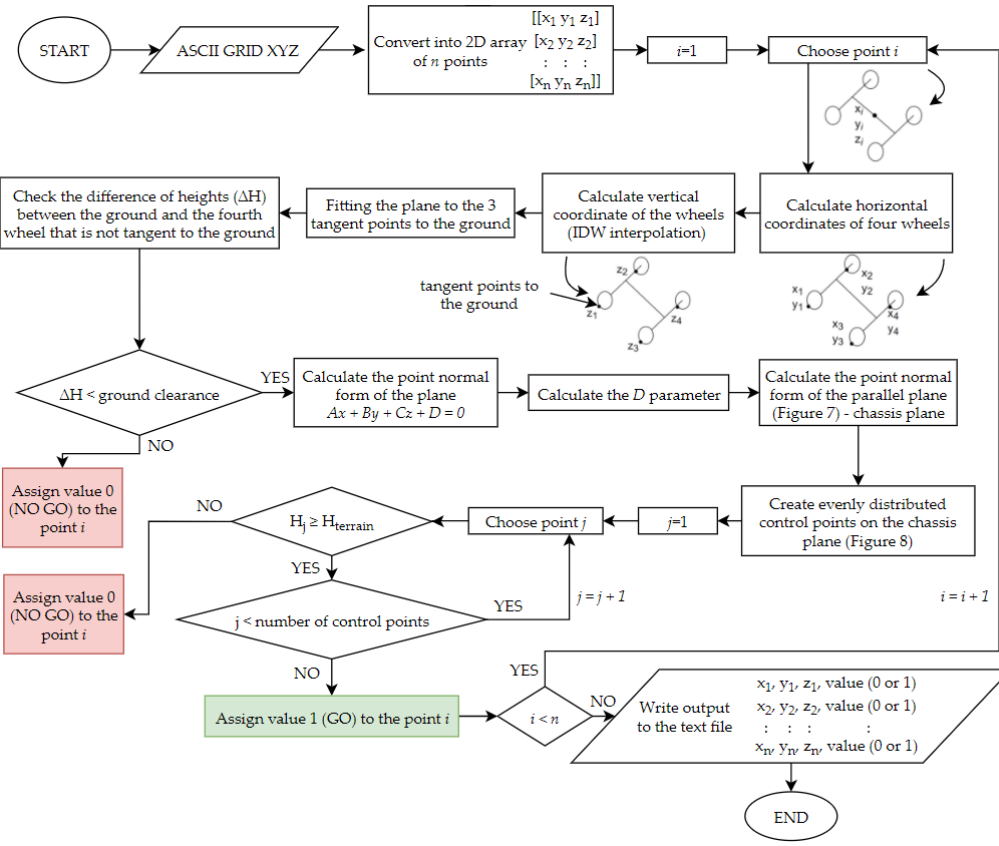
Figure 10. Block diagram of the process.